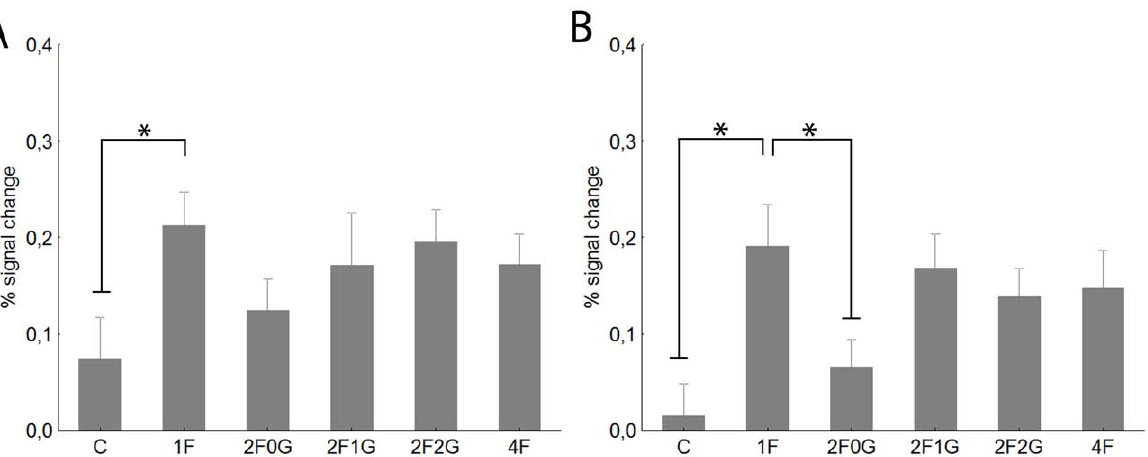
Figure 3. Average peak activation profiles ( ± standard error) of the left FFA. A. Contralateral stimulation. B. Ipsilateral stimulation. For conventions see Fig. 2.